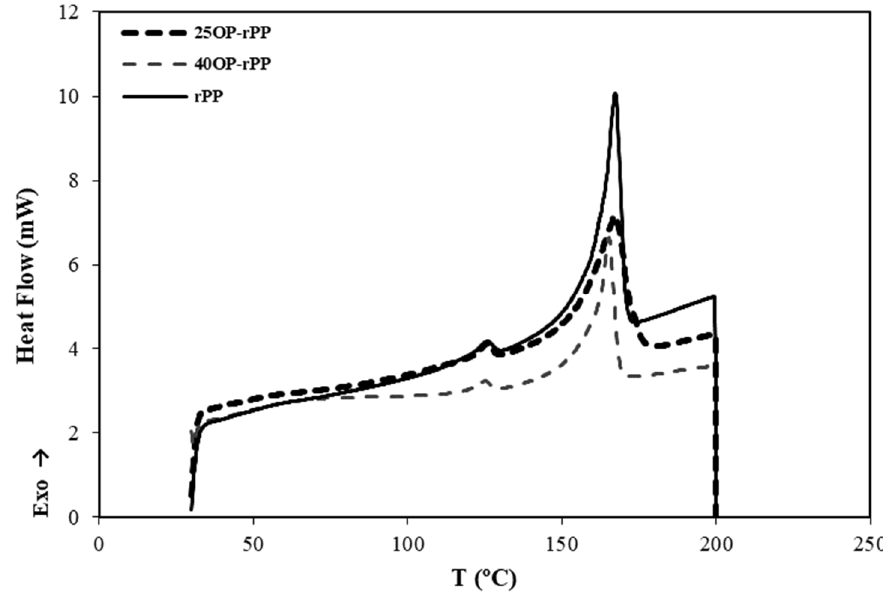
Figure 10. Thermograms resulting from the DSC performed on rPP and composites with 25 and 40 wt% OP without additives.